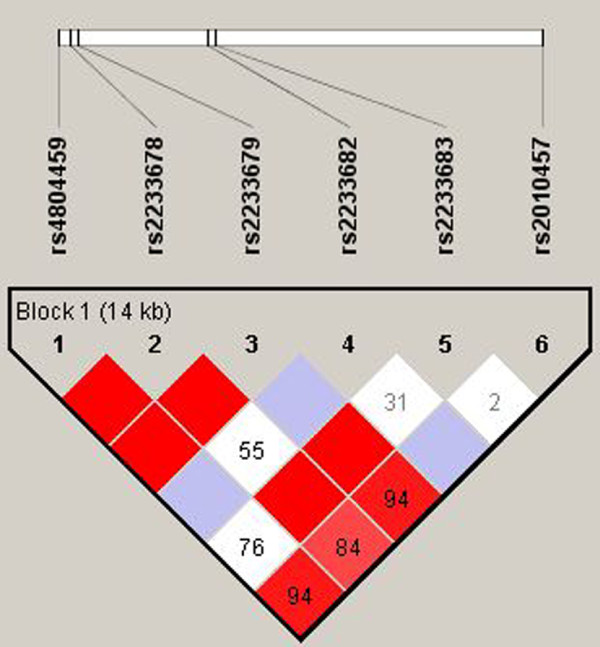
Pairwise linkage disequilibrium between the six genotyped SNPs in a 14 kb region of PIN1 (Haploview 4.1) for combined group (n = 321) of all patients (LOAD, EOAD and FTD) and controls. Numbers inside the squares represent the D' value expressed as a percent. Squares without numbers represent D' values of 1.0, indicative of complete linkage disequilibrium. Darker-shaded squares represent pairs with LOD score for linkage disequilibrium of = 2, light grey squares represent D' = 1 but LOD <2, and white squares represent LOD <2 and D' <1.0.